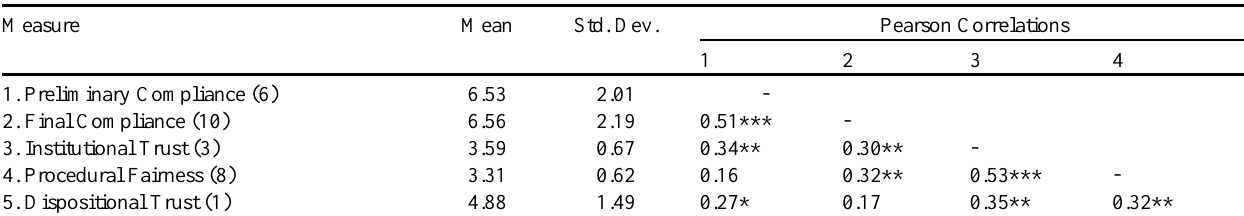
Table 1 . Descriptives and intercorrelations for primary measures. Measure Mean Std. Dev. Pearson